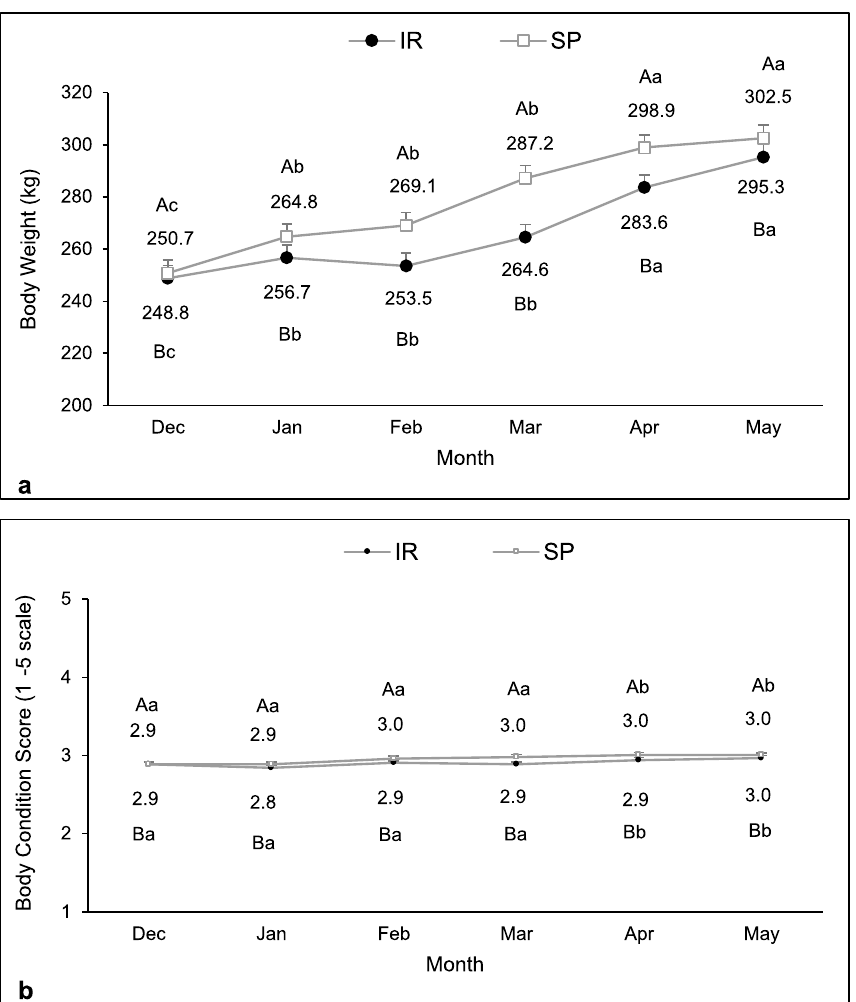
Figure 5. Body weight ( a ) and body condition score ( b ) evolution of heifers kept in the silvopastoral (SP) or intensive rotational (IR) grazing systems from December 2015 to May 2016. There was a significant effect of system and month on body weight and body condition score. A,B Different capital letters indicate a significant difference between systems. a,b,c Different lowercase letters indicate a significant difference between